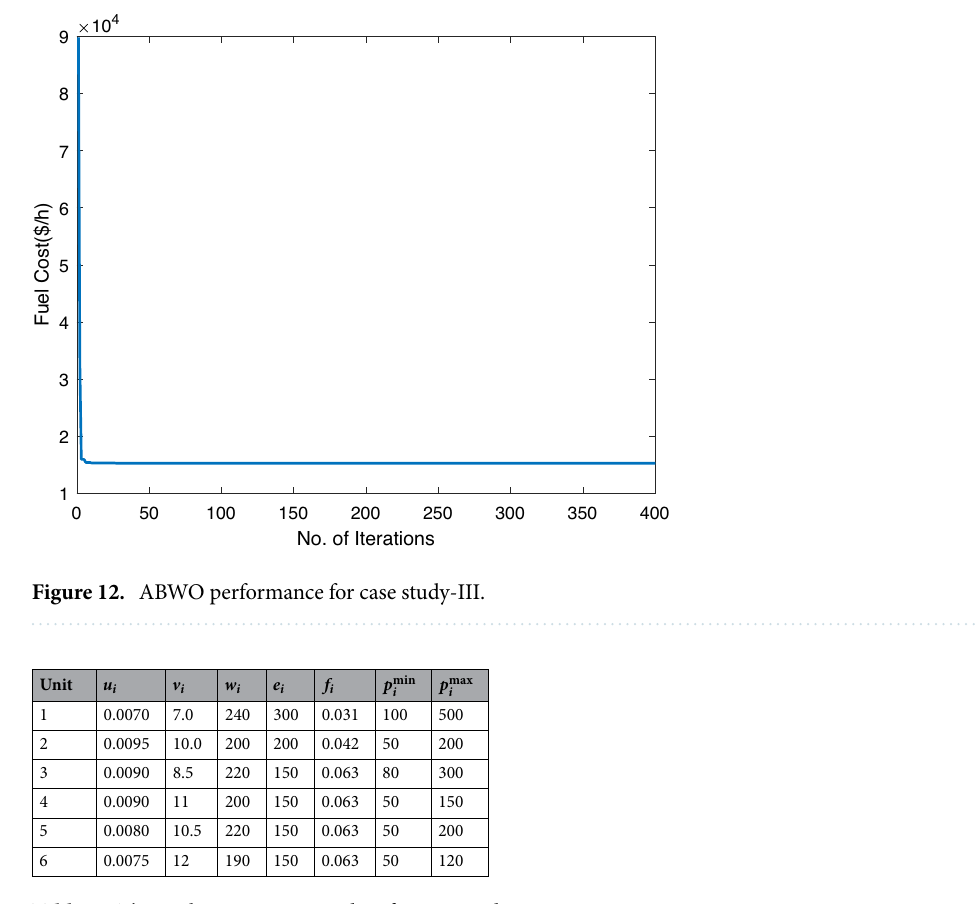
Table 8. Thermal units cost input data for case study-III.